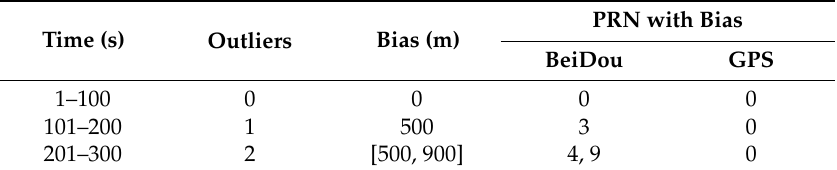
Figure 4. Horizontal radial error of open sky static scenario.